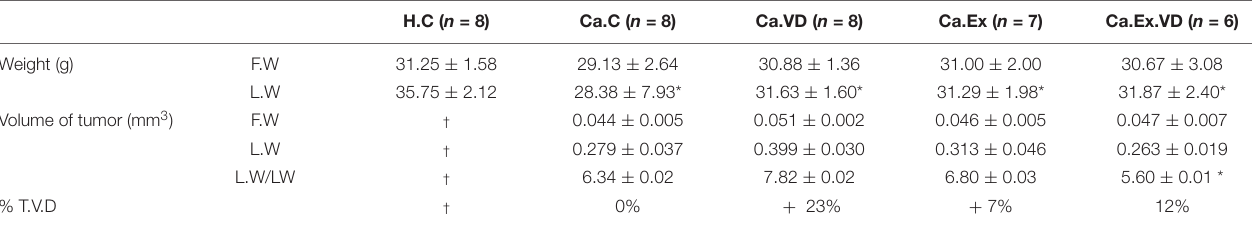
TABLE 3 | Changes in body weight and tumor volume of research groups after 6 weeks of treatment (interval exercise training and vitamin D supplementation) (means ± SE).